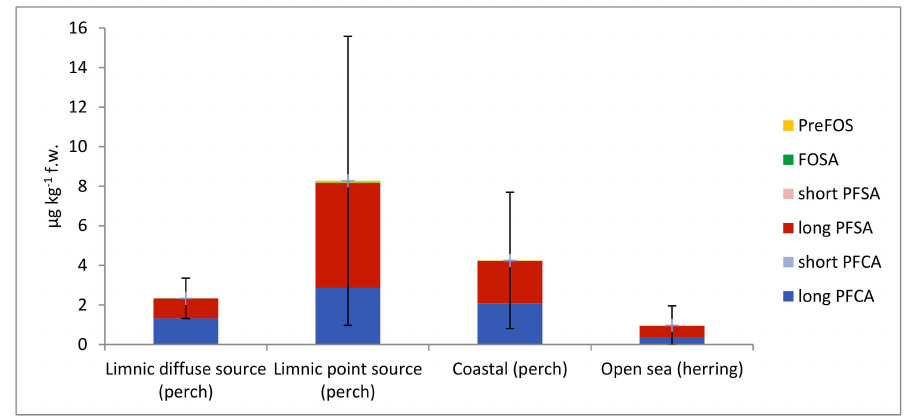
Figure 5. Mean concentrations of PFASs in fish from di ff erent types of sampling sites and standard (cid:80) deviation of average 22 PFAS. PFPeA is excluded because it was not analysed for